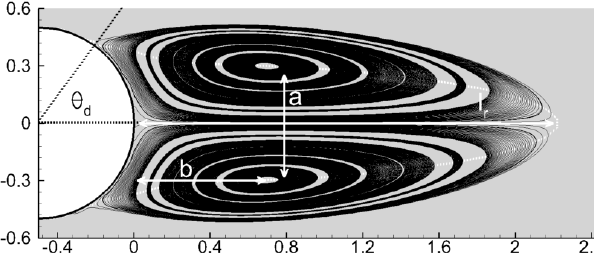
Figure 12. Recirculating region at Re = 40 (MNH–IBM, 20pts /D cyl ): definition of the θ d ( ◦ ) separation angle, l r recir- culating length and (a ; b) vortex core location. The distance is dimensionless by D cyl .